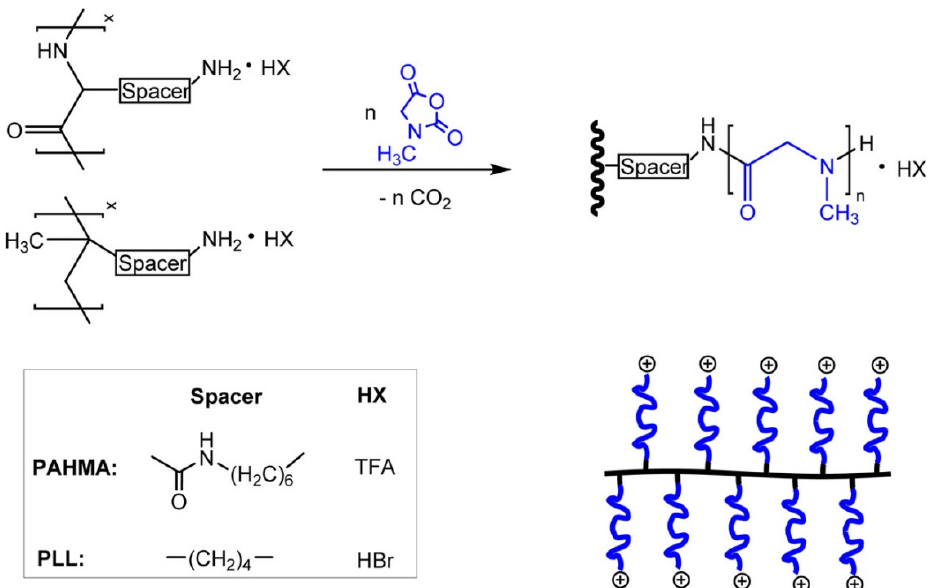
Figure 11. Synthesis of cylindrical polysarcosine brushes (Adapted from ref. [84]. Copyright 2015, American Chemical Society).